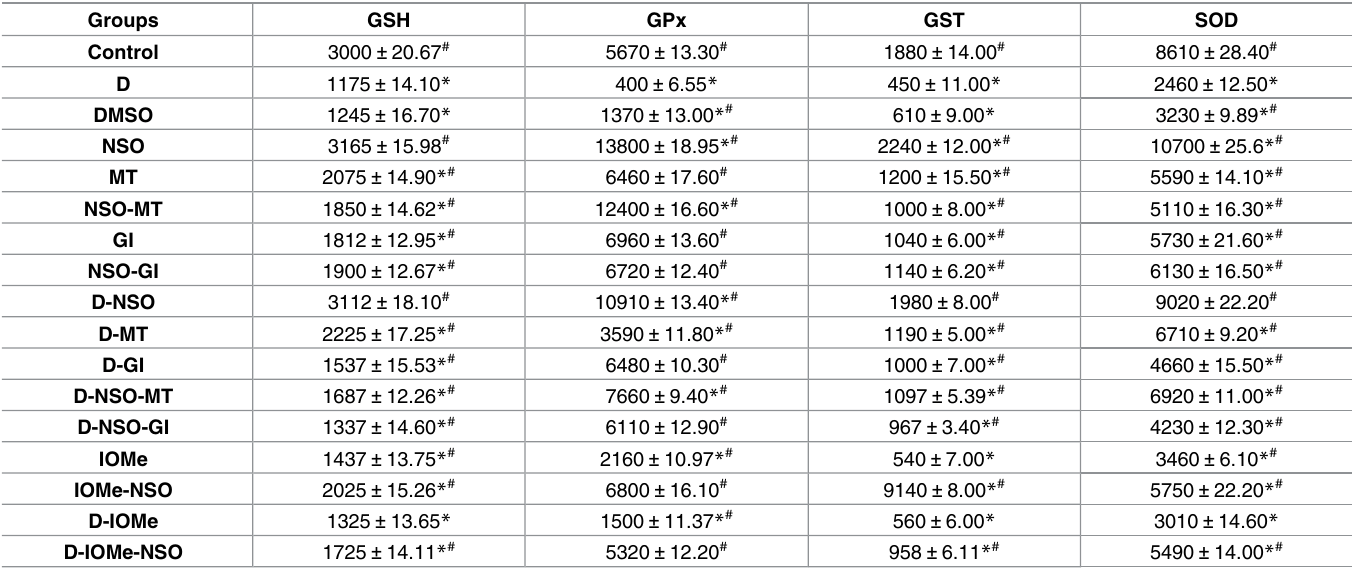
Table 3. Antioxidant markers alterations in the brain of diabetic rats and after treatment with NSO, antidiabetic drugs, combination therapy and I-OMeAG538. Groups